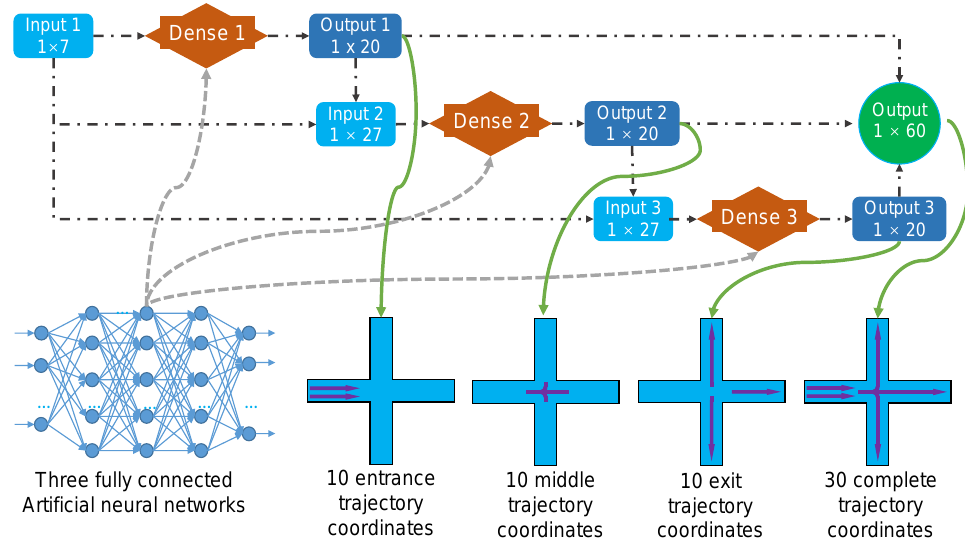
Figure 3. The structure of the proposed ANN. Table 1. The configuration of the proposed dense